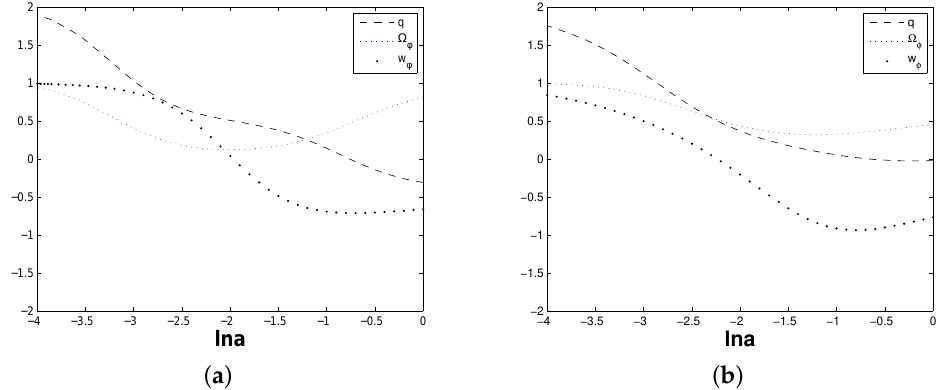
Figure 5. ( a ) The evolutions of Ω φ , w φ and the deceleration parameter q by the initial condition ( x ) = ( 0.85,1.5 ) around P ( λ , α ) = ( 0.5,0.01 ) . ( b ) The evolutions of Ω φ , w φ and 0 , y 0 1 corresponding to the deceleration parameter q by the initial condition ( x 0 , y 0 ) = ( 0.9,1.0 ) around P 3 corresponding to ( λ , α ) = ( 1.2, − 0.8 ) .